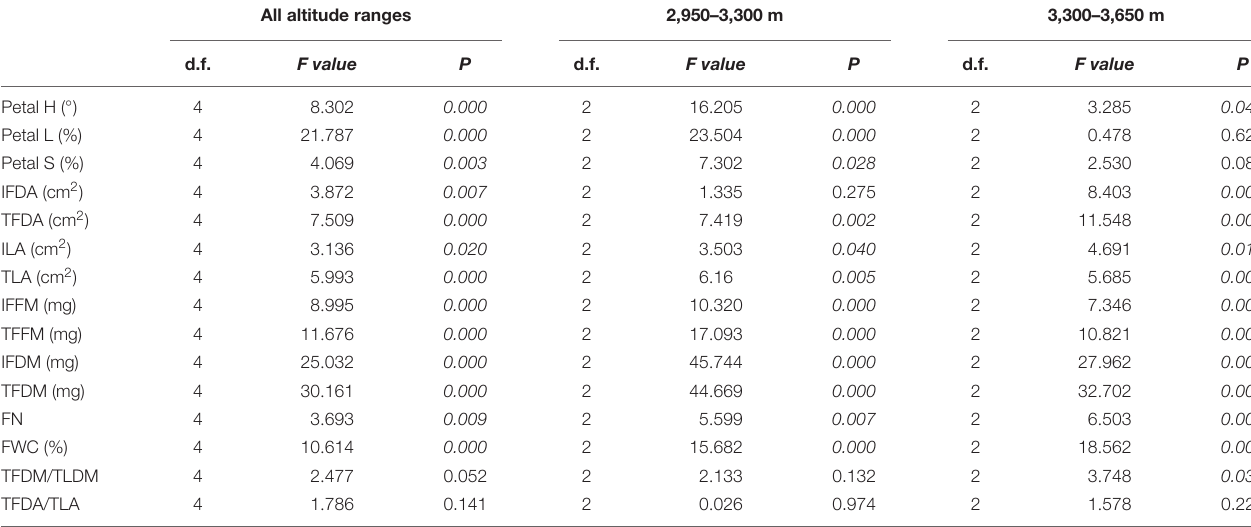
TABLE 2 | Altitudinal effects on floral morphological traits and biomass at different altitude